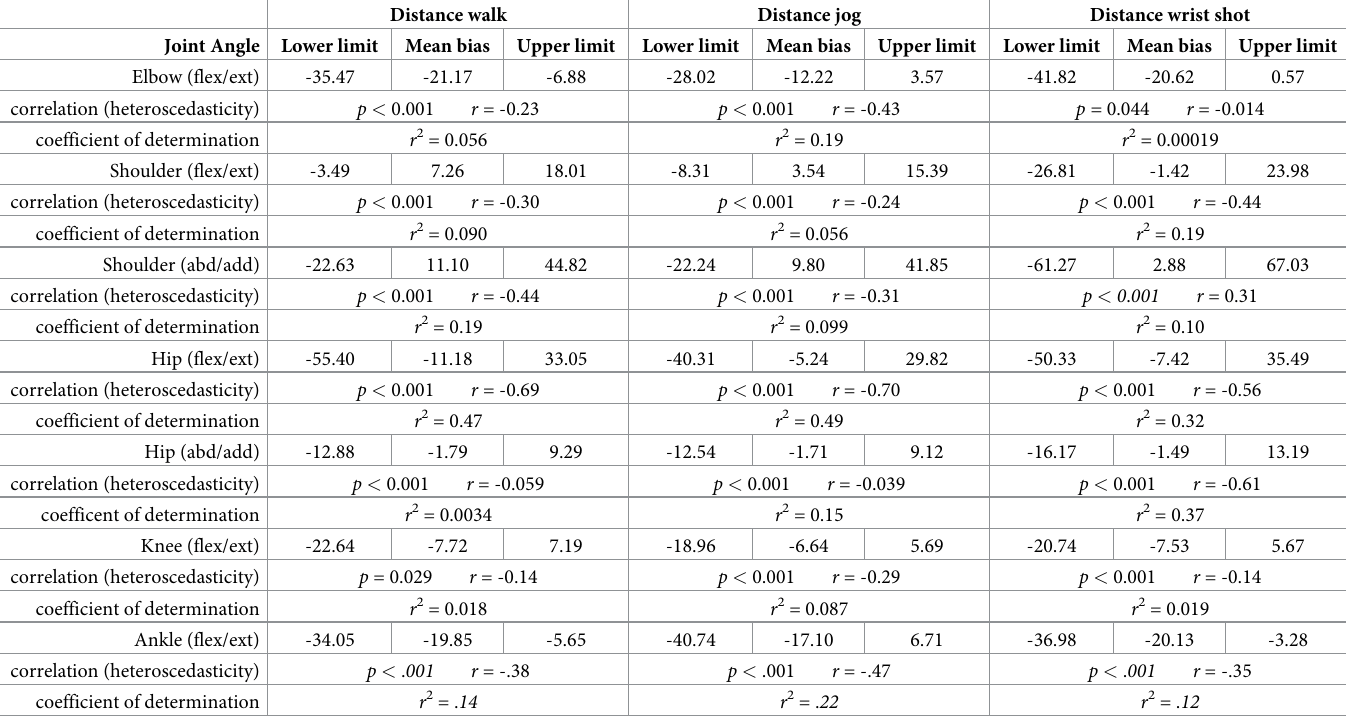
Table 6. Limits of agreement and mean bias for all movements with distance.